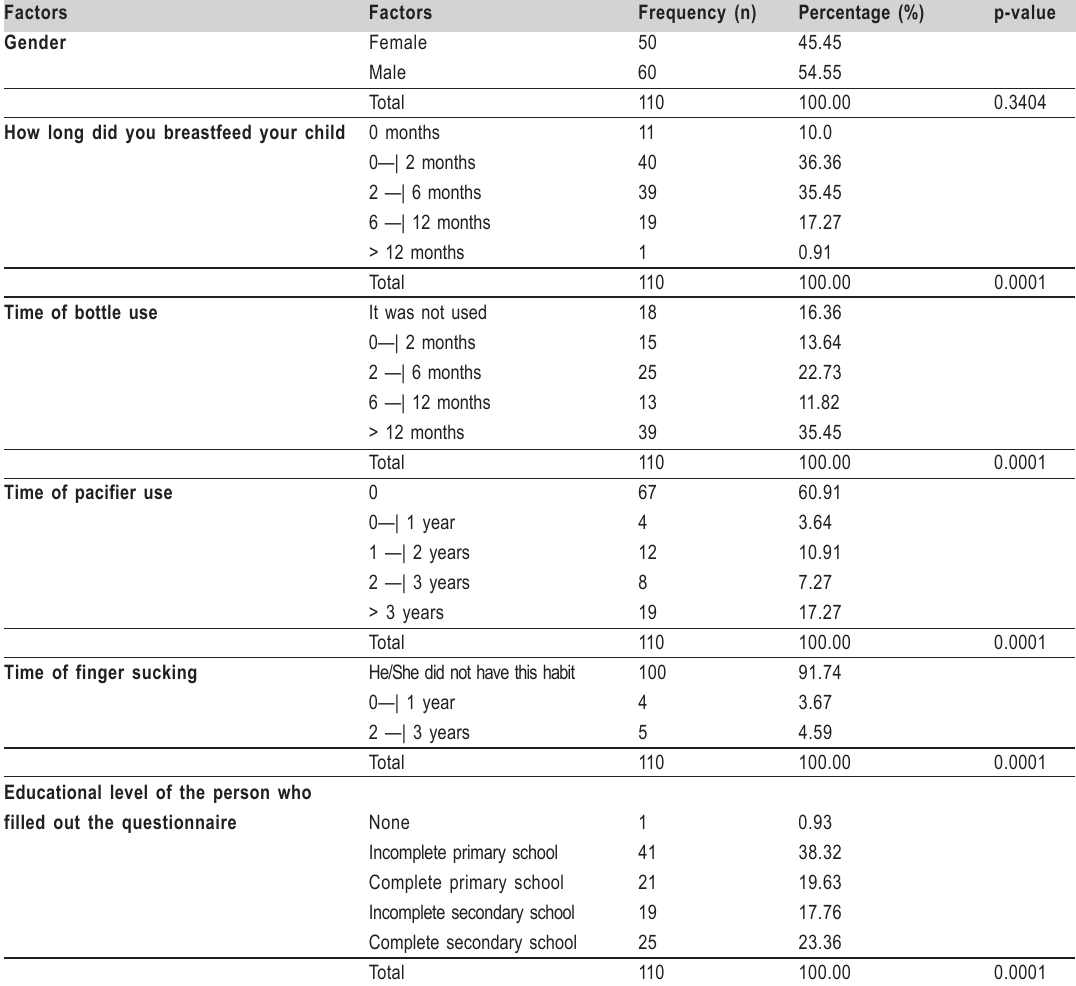
Table 2. Frequencies, percentages and p value calculated by chi-square test for the hypothesis of